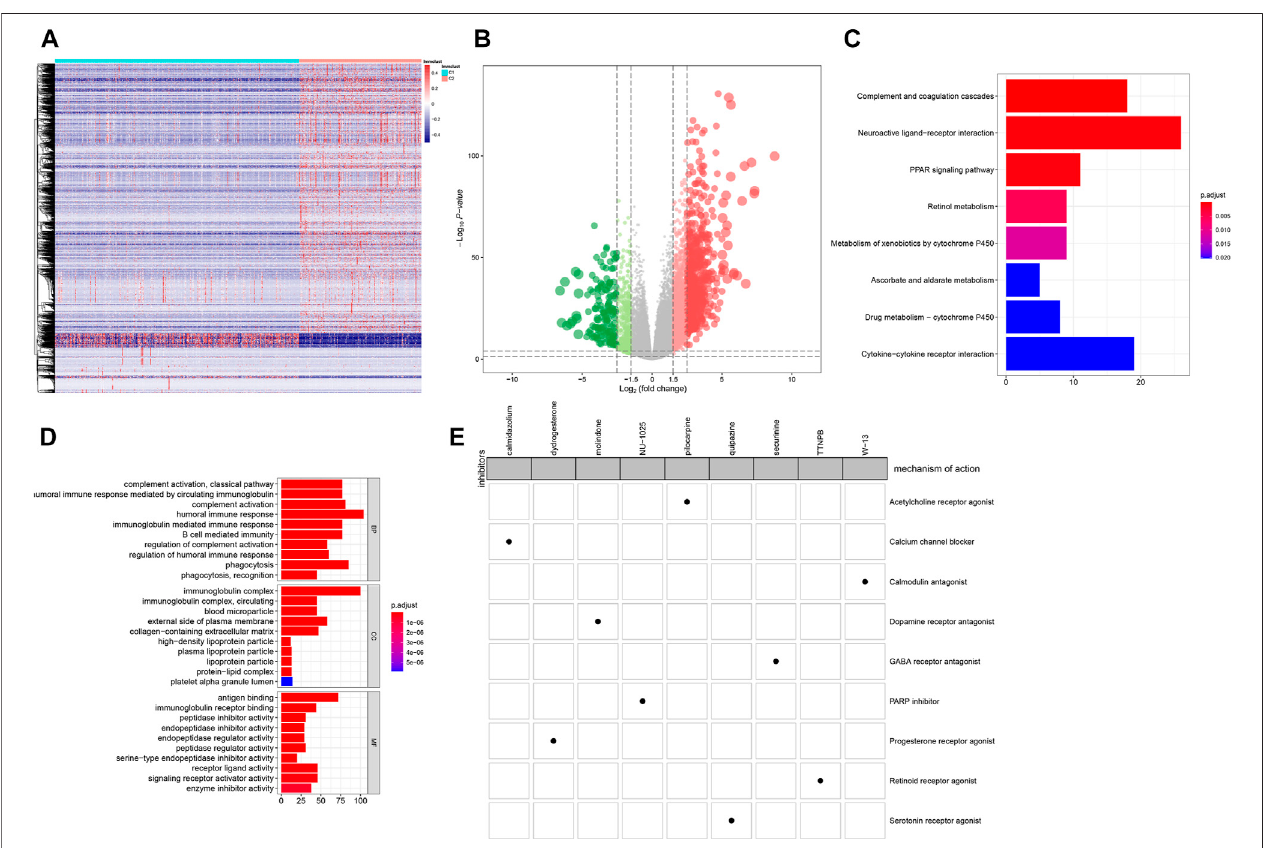
FIGURE 6 | CMap analysis identi fi es candidate small molecular inhibitors for ccRCC (A) Heatmap depicting all DEGs between C1 (blue) and C2 (red) (B) Volcano plotsup-regulatedgenes(redbubbles)anddown-regulatedgenes(greenbubbles)inC1comparedtoC2 (C) BarplotsofthetoptenenrichedKEGGsignalingpathways (D) Bar plots of the top ten GO function annotation analysis results including biological processes (BP), cellular component (CC) and molecular function (MF) categories. Red suggests high enrichment and blue suggests low enrichment (E) Heatmap demonstrating each inhibitor (perturbagen) and its shared mechanisms of action (rows) via the CMap